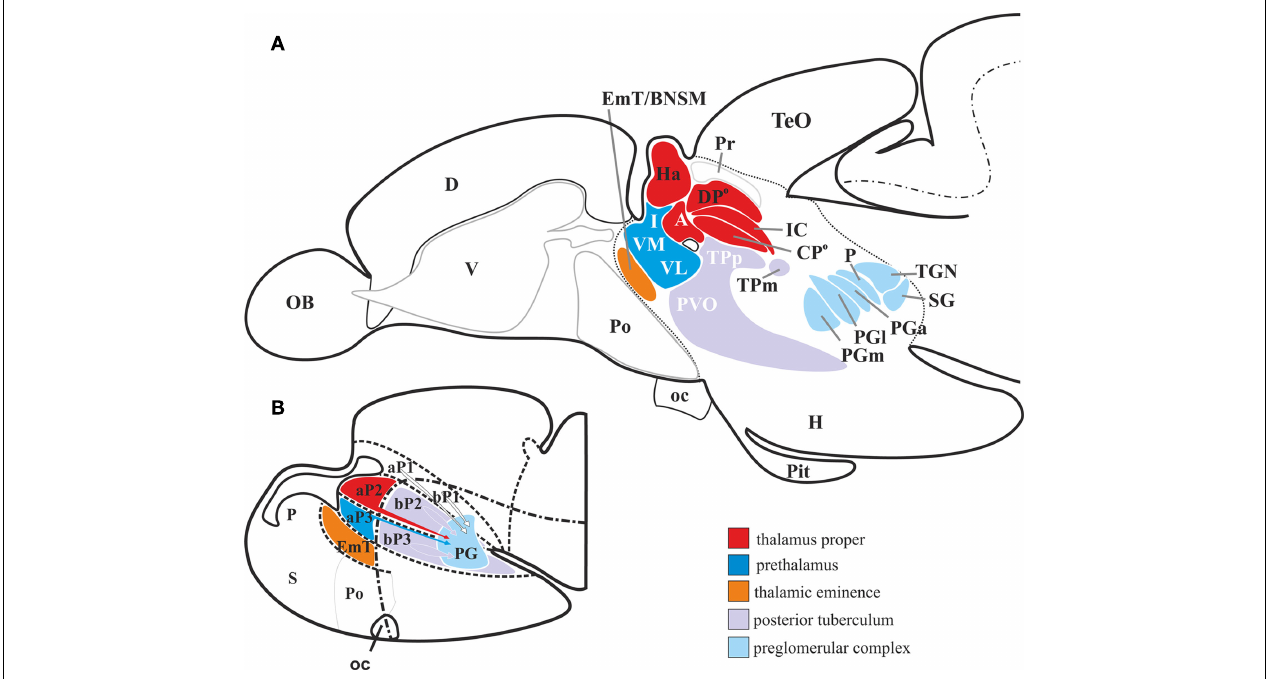
FIGURE 2 | Schematic drawing of the wider thalamus in the larval and adult zebrafish. (A,B) The alar plate prosomere 2 [aP2, red in (B) ] derived dorsal thalamic nuclei [red in (A) ] are located dorsally to the zona limitans intrathalamica.These are the habenular nuclei, the auditory dorsoposterior (DP o ), the intercalated (IC), the visual centroposterior (CP o ), and the anterior thalamic nuclei (A) .The alar plate prosomere 3 (aP3) derived ventral thalamic